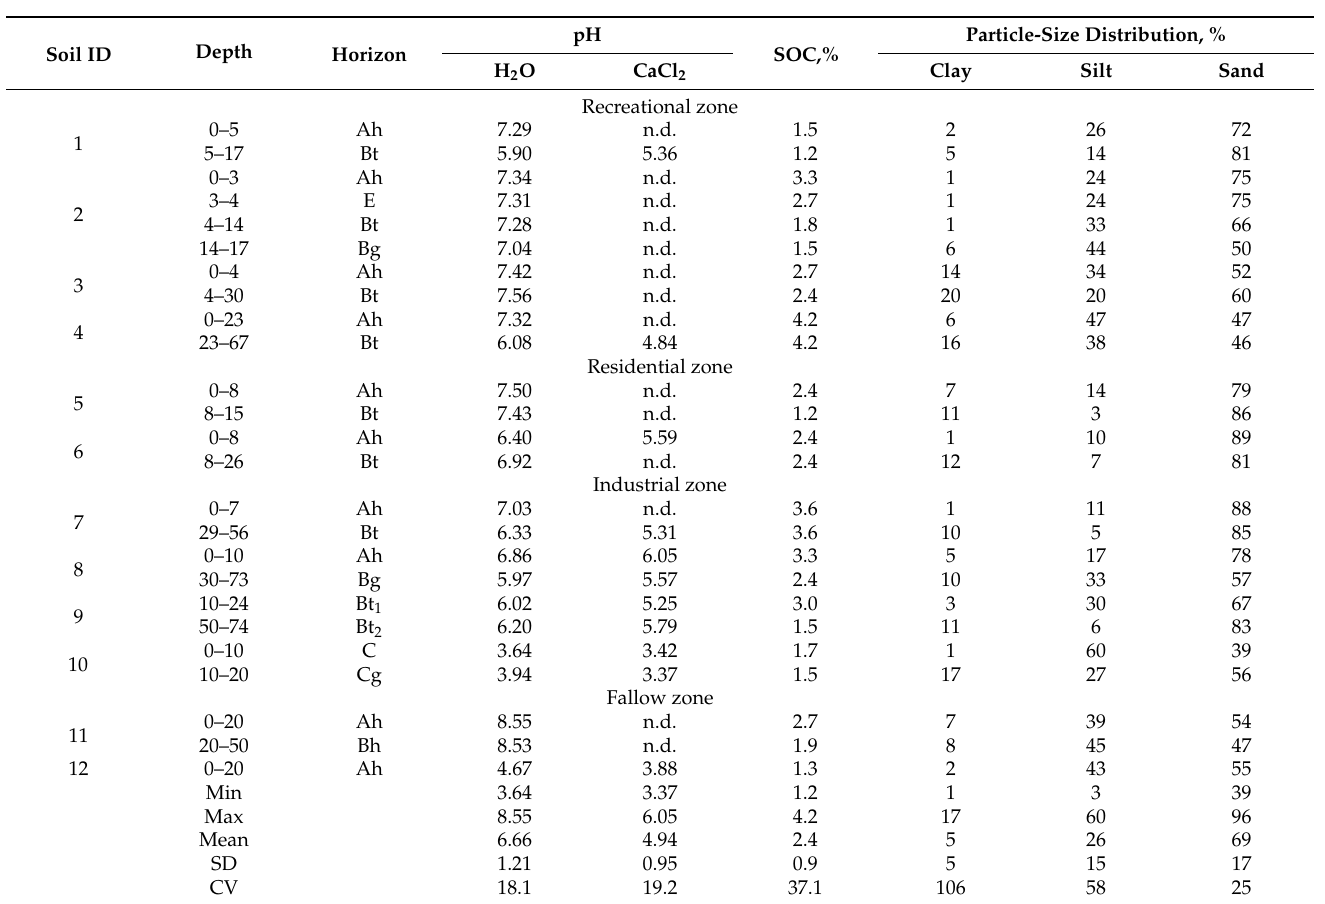
Table 3. The physic-chemical characteristic of study soils. The soil ID correspond to Table 1. SOC, %—soil organic carbon; SD—standard deviation; CV—coefficient